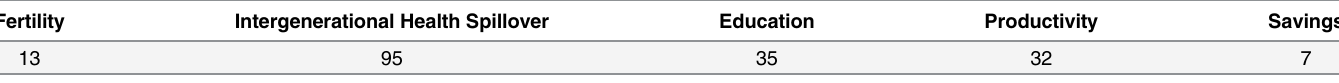
Table 2. Pathways: Women ’ s health and economic development.